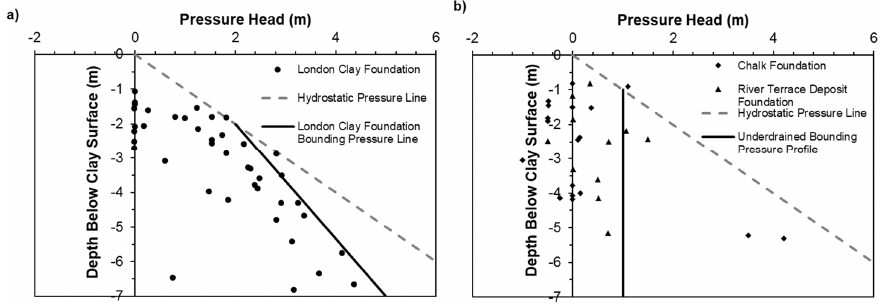
Figure 4. Pore water pressure profiles for London Underground Ltd. clay embankments (likely con ‐ sisting of uncompacted London Clay fill) constructed in the late 19th century, measured by Ridley, et al. [48] in spring 2001 and organised by foundation material including: ( a ) stiff London Clay and ( b ) river terrace deposits and chalk (modified after Briggs, et al. [45] ).